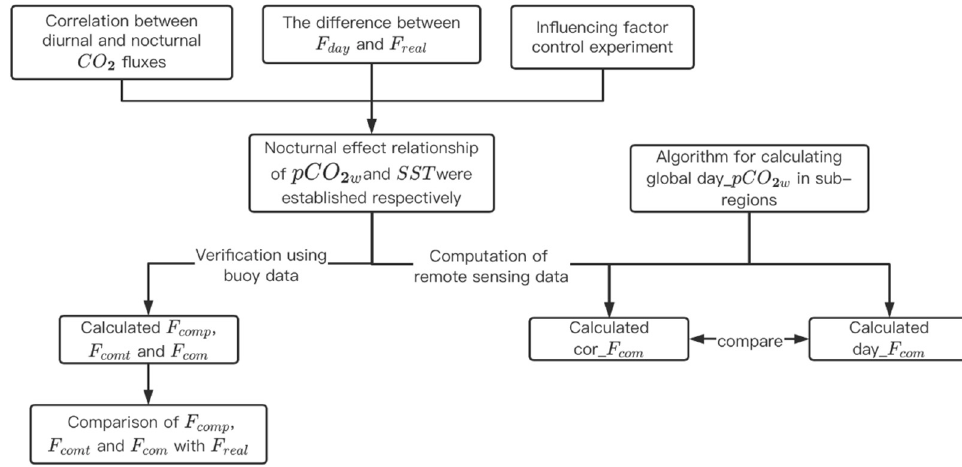
Figure 16. Research flow chart.